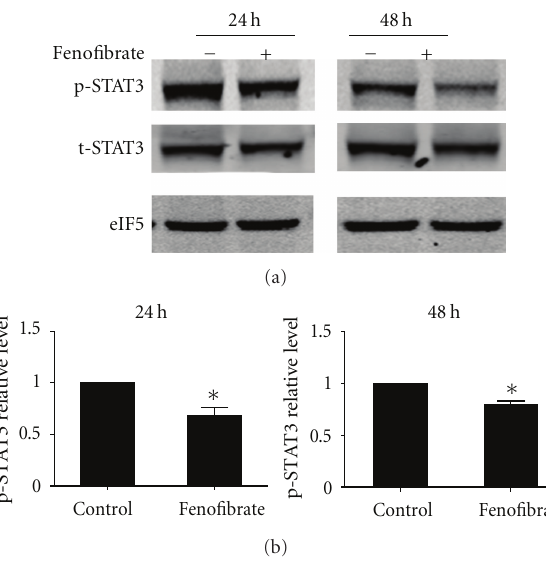
di ff erentiation system. (a) Total T cells were isolated from mouse spleens and induced di ff erentiation to Th17 cells with 10 ng/mL TGF- β and 40ng/mL IL-6 plus 20 μ M fenofibrate or solute control. 24 and 48 hours later, the phosphorylation state of STAT3 was analyzed with western blot. Data shown here represent one of three independent experiments. Graphs in (b) indicate the statistic significance of STAT3 phosphorylation state relative to the control group. n = 3-4, ∗ P < 0 . 05 versus